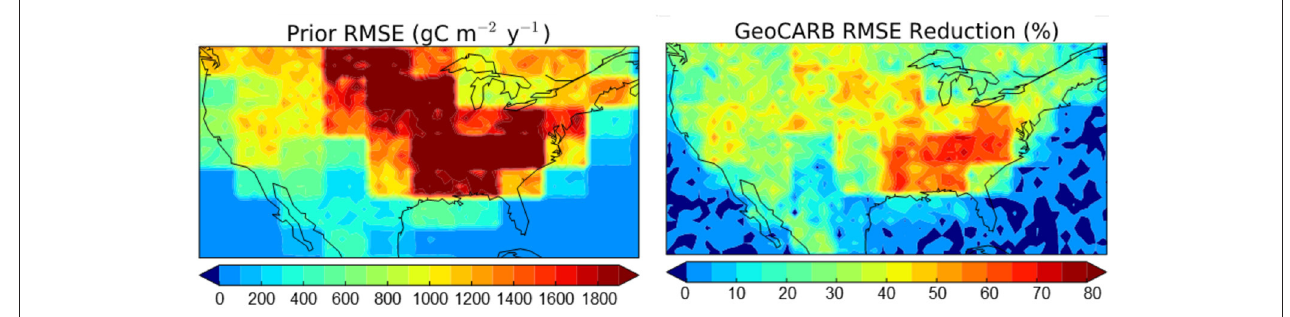
FIGURE 4 | (Left) Prior uncertainty for the CONUS experiment for the month of June (expressed in gC m − 2 y − 1 ), equal to the absolute difference between the Lund-Potsdam-Jena [LPJ, (Sitch et al., 2003)] and CASA-GFEDv3 terrestrial fluxes. The majority of the prior uncertainty is in the growing regions of the US. (Right) The reduction in ensemble daily flux RMSE for June, expressed as a percentage, when GeoCarb pseudo-observations are used to update the perturbed prior fluxes.